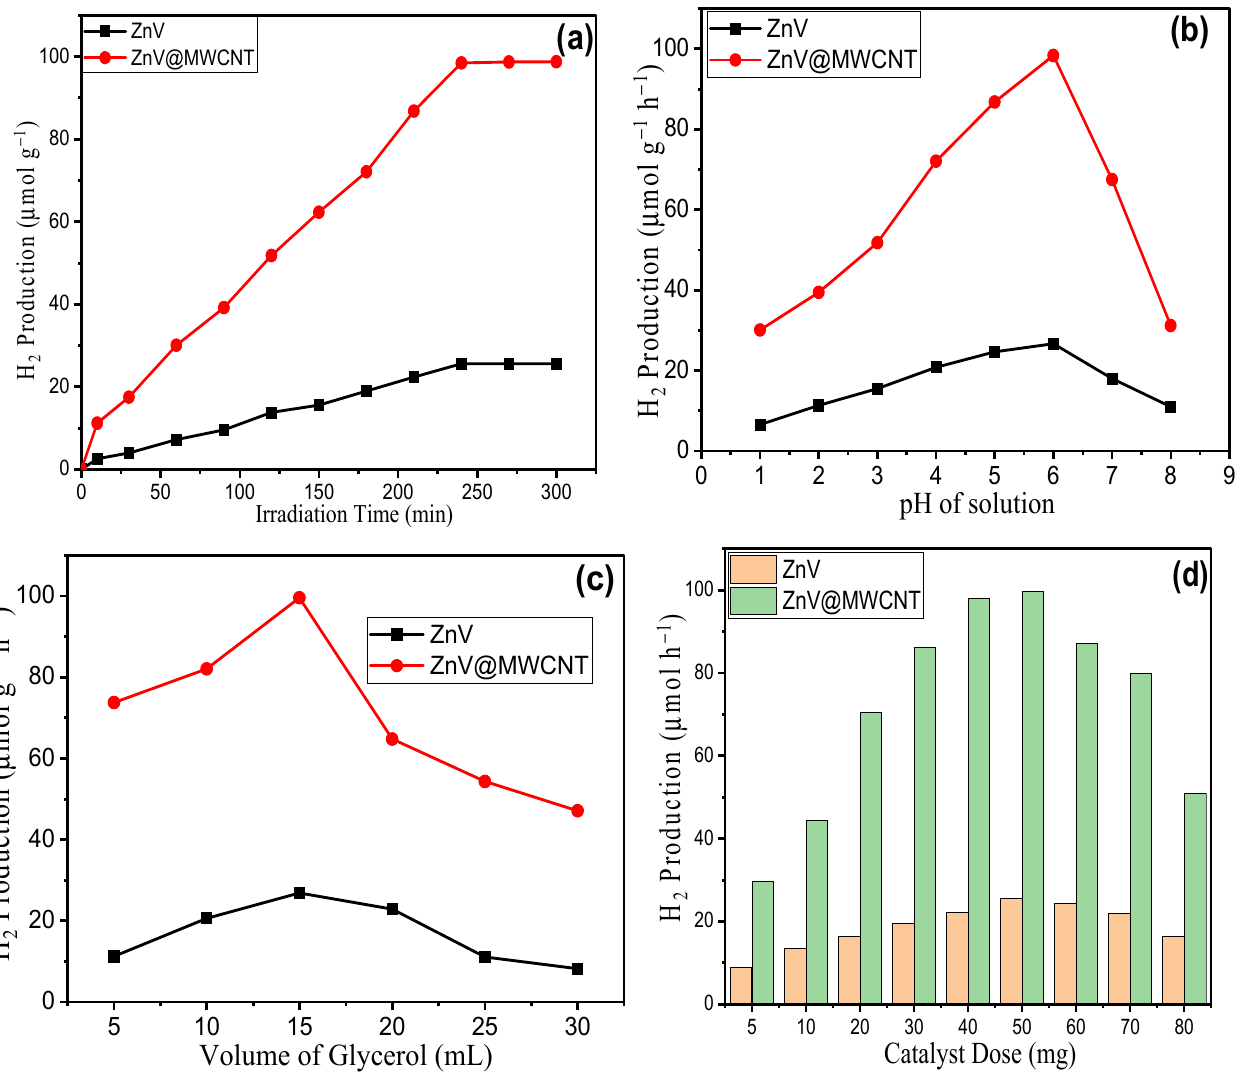
Figure 10. Effects, observation, and optimization of ( a ) irradiation time, ( b ) pH of the media, ( c ) concentration of glycerol, and ( d ) catalyst dose.